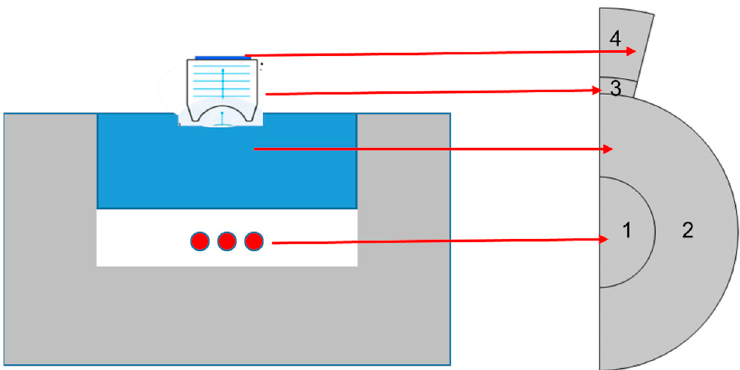
Figure 2. Geometry used for modelling in COMSOL (on the left) relating to the experimental setup. region 1: microparticles, region 2: water, region 3: piezoelectric region, region 4: backing layer .